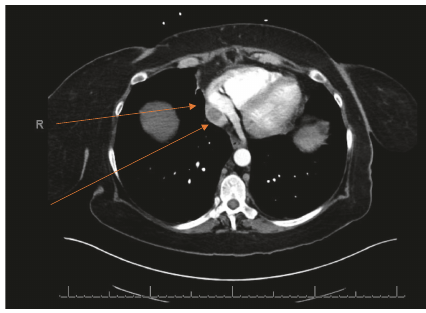
Figure 3: Extension of IVC thrombus to the right